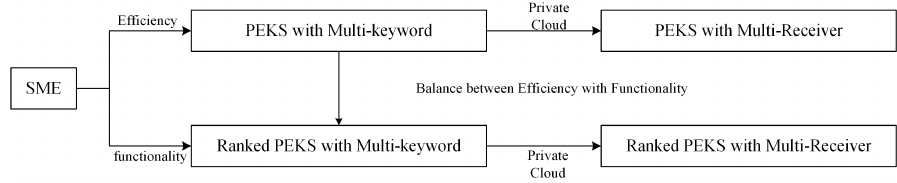
Figure 2. Relational graph of